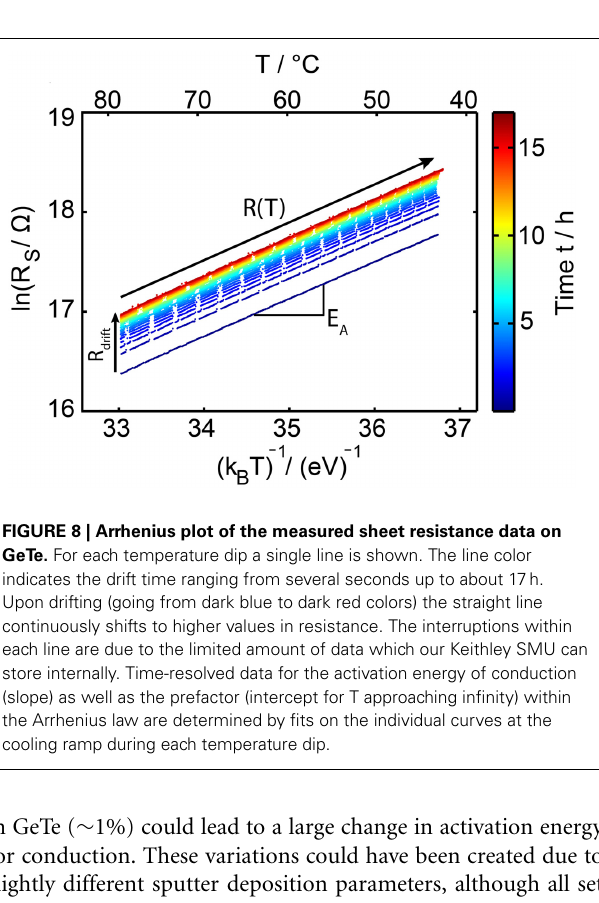
FIGURE 9 | Time-resolved measurement of activation energy (top) and Arrhenius prefactor (bottom) for the phase change materials Ge 2 Sb 2 Te 5 (left), AgInSb 2 Te (middle), and GeTe (right). The values are determined by fitting a straight line to the experimental data in the Arrhenius plot. While Ge 2 Sb 2 Te 5 shows a clear increase only in activation energy but no change in the prefactor, AgInSb 2 Te and GeTe show an increase in both E A and R ∗